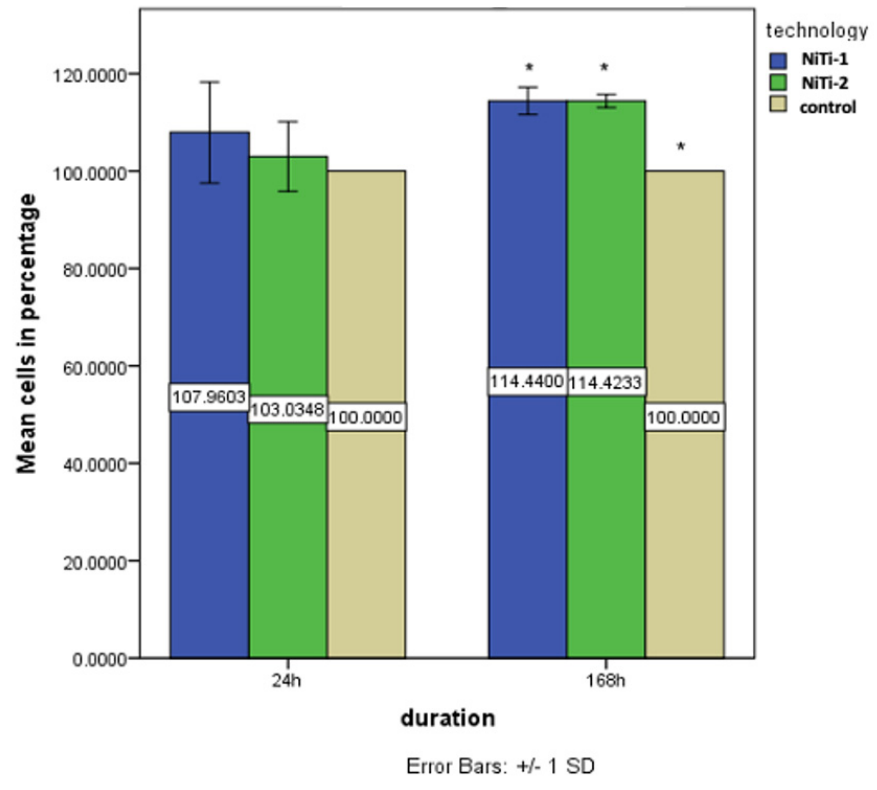
Figure 6. Cell viability for the three groups (NiTi-1, NiTi-2 and control) at 24 h and 168 h. (* p < 0.05)